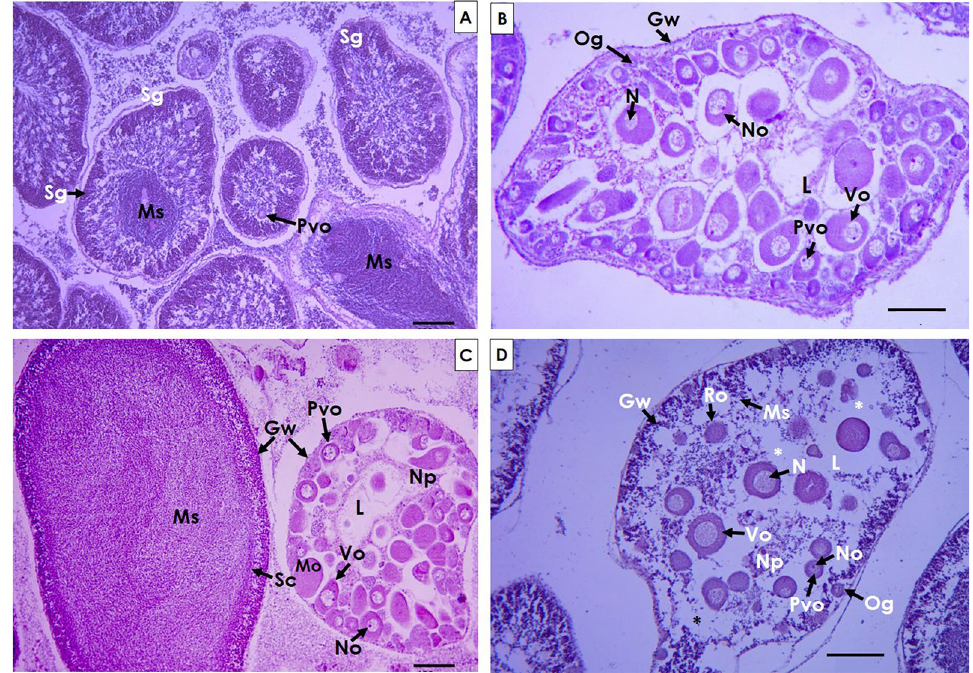
Figure 5. Stages of gametogenic development in hermaphrodites of T. roseus : ( A , B ) growth stage, ( C ) maturation stage, ( D ) spawning stage. Gw gonad wall, L lumen, Mo mature oocytes, Ms mature spermatozoa, N nucleus, No nucleolus, Np nutritive phagocytes, Og oogonia, Pvo previtellogenic oocytes, Ro remaining oocytes, Sc spermatogenic columns, Sg Spermatogonia, Vo vitellogenic oocytes. The asterisk indicates empty spaces due to the release of gametes. Scale bars are 100